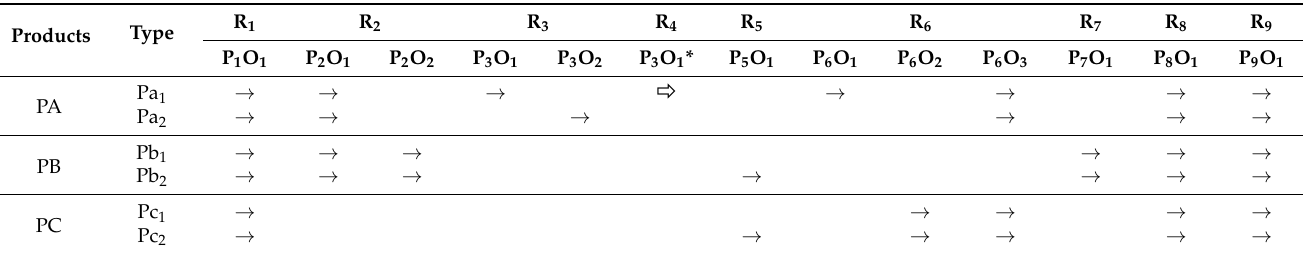
Table 1. Schematic of process planning for products.